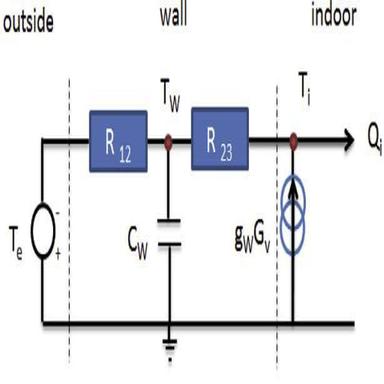
RC network of the test wall.